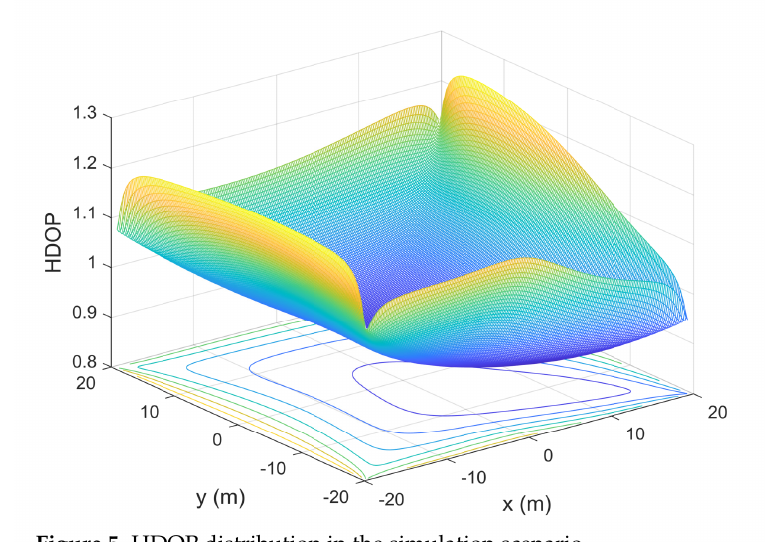
Figure 5. HDOP distribution in the simulation scenario.